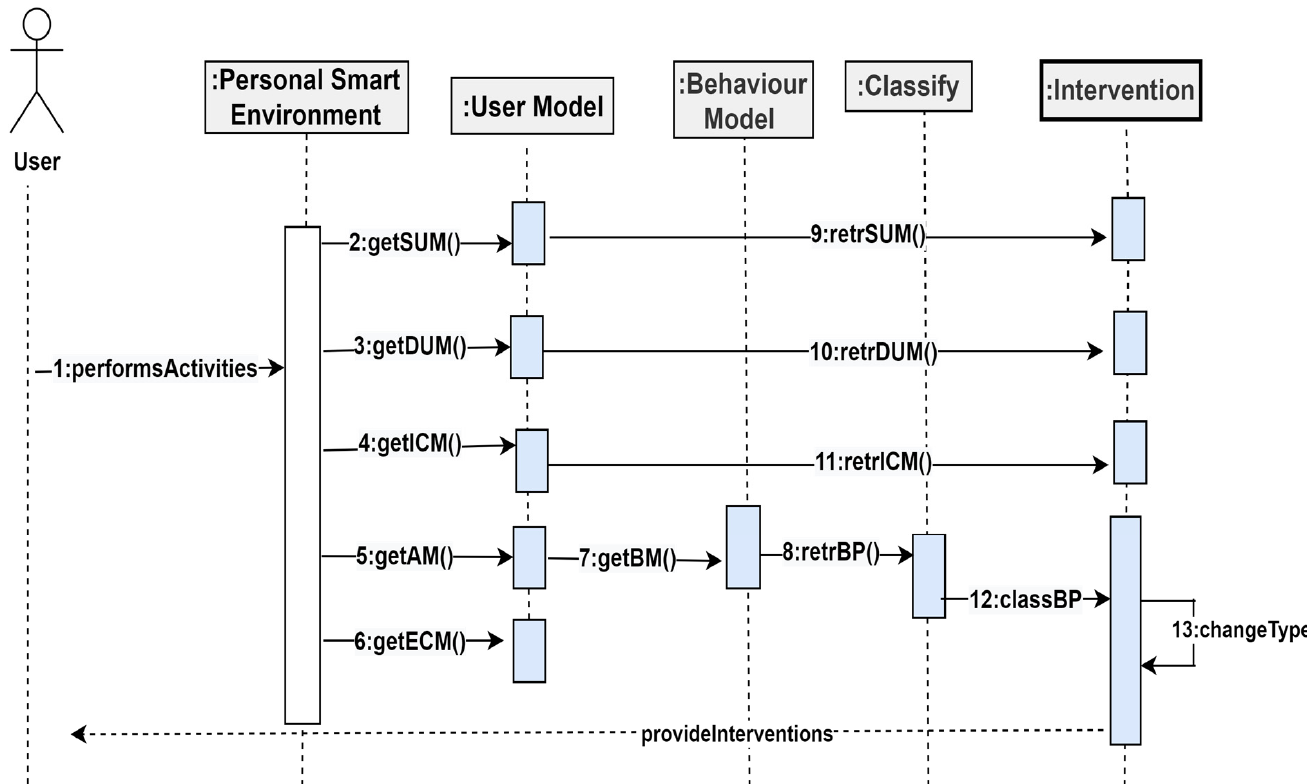
Figure 9. Component Interactions